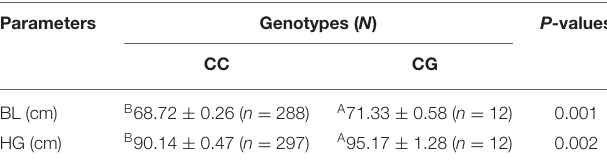
TABLE 7 | Relationship between the A85G locus of the GDF9 gene and growth parameters in Shaanbei white cashmere (SBWC)